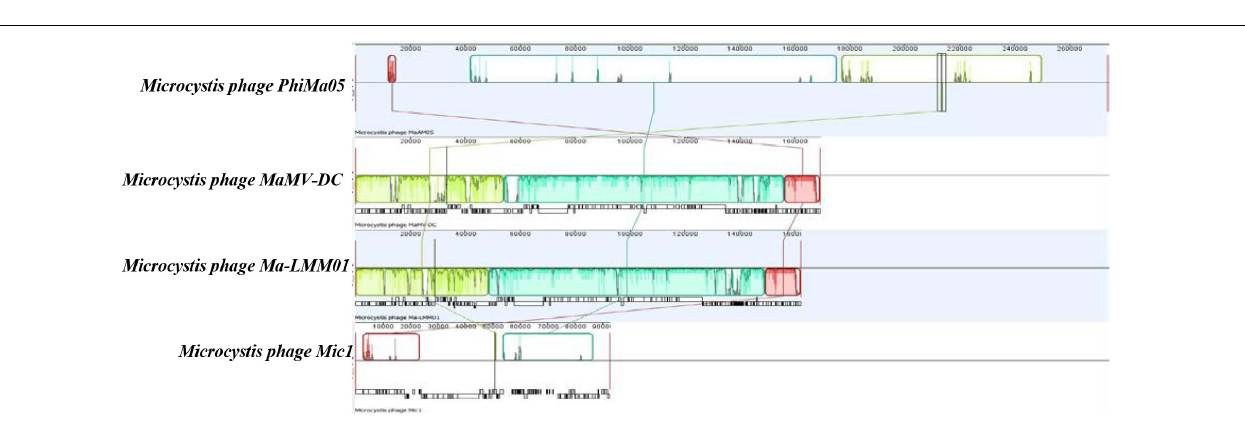
FIGURE 9 | Comparative genome analysis of phage PhiMa05 genome with Microcystis phages. The colored collinear blocks indicate homologous regions between genome sequences while the height of the similarity profile in the collinear blocks indicates average level of conservation in the regions of the genome sequence.